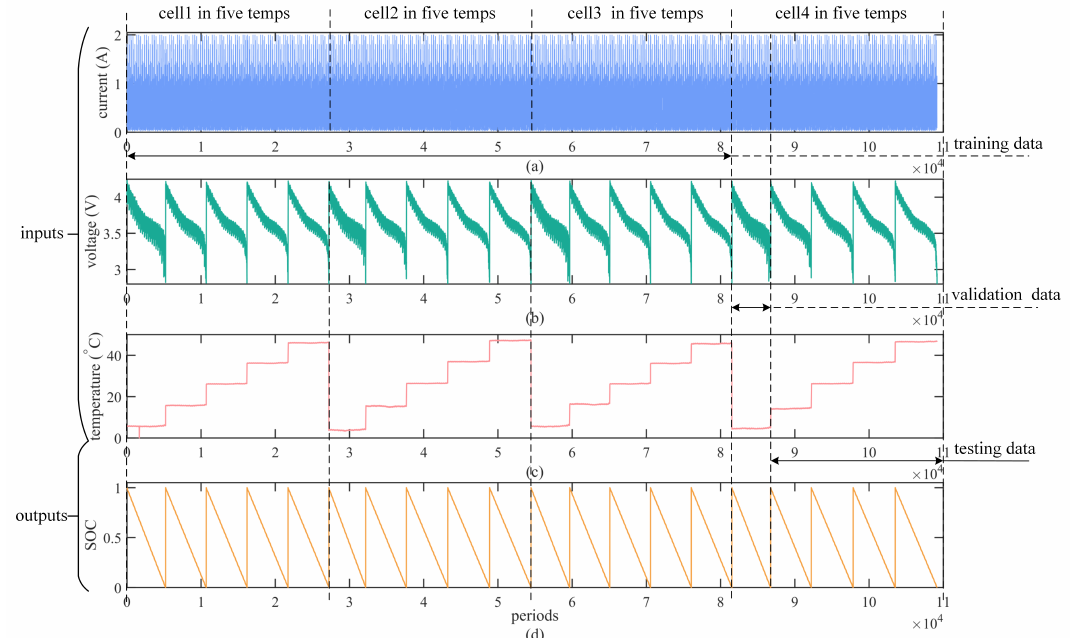
Figure 8. Selected data for training, validation, and testing of the algorithm. ( a ) current profile, containing cycling FUDS periods, ( b ) measured cell voltage, ( c ) five measured temperature (5 ◦ C, 15 ◦ C, 25 ◦ C, 35 ◦ C, 45 ◦ C), and ( d ) calculated SOC, as output target. Data are collected together in time series (1Hz frequency) and can exchange the sequential order to achieve different division